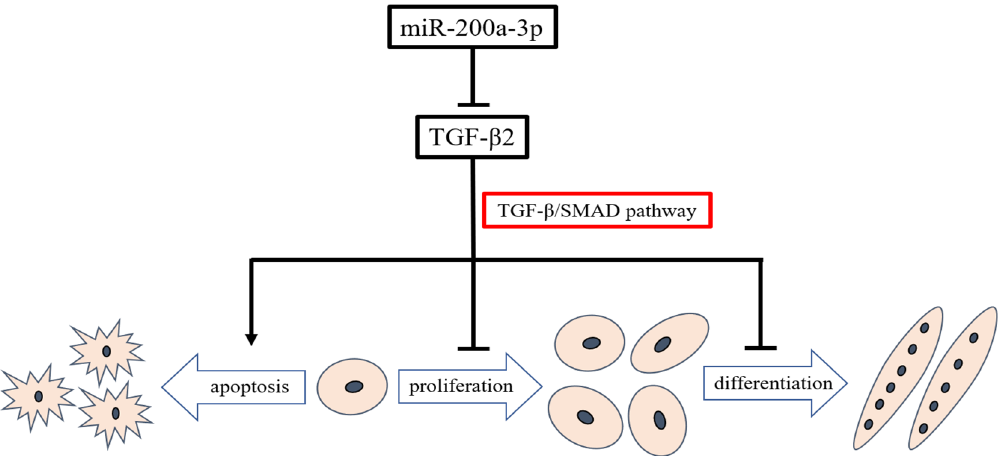
Figure 11. Model illustrating the miR-200a-3p-mediated regulatory pathway in chicken skeletal muscle satellite cells.